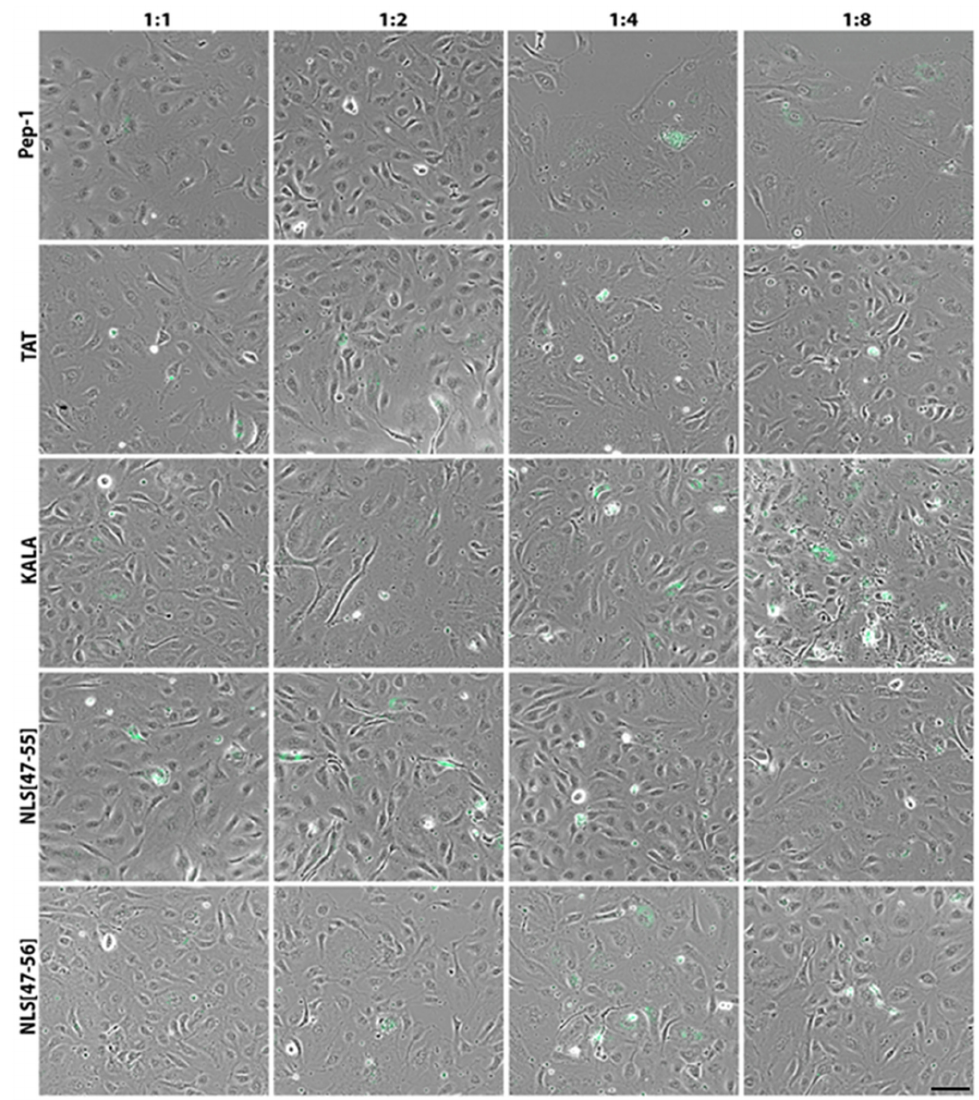
Figure 6. Results of 24 h culture in the presence of complexes in CRs of 1:1, 1:2, 1:4 and 1:8. The complexes were formed using incubation of 2 μ g pmaxGFP with chosen CPPs at 21 °C for 15 min. Bar = 50 μ m. CR, charge ratio.